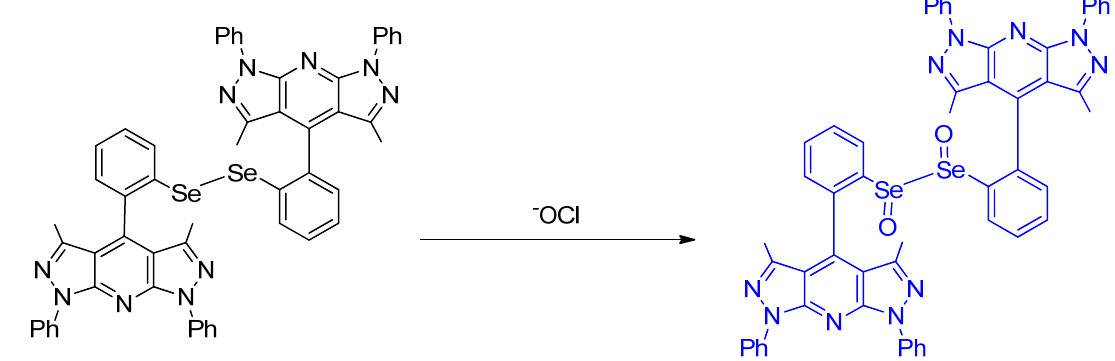
Figure 33. Proposed mechanism of the probe for detection of hypochlorite by Kim et al. Cysteine hydropersulfide (Cys–SSH) plays important roles in the synthesis of sulfur– containing cofactors, cellular signaling, and modulation of enzyme activities. Han et al. in 2016 developed Cy – DiSe , a NIR fluorescent probe for the selective detection of Cys–SSH, based on a heptamethine cyanine probe skeleton. Two moieties were introduced to the probe with a different purpose; bis(2–hydroxyethyl) diselenide can be readily reduced by Cys–SSH due to its stronger nucleophilicity than that of other biothiols (Figure 34); this moiety, therefore, promotes the selectivity of the probe towards Cys–SSH; the terminal galactose residue can allow the probe to target the liver. Cy–DiSe exhibited a ratio fluorescence response to Cys–SSH. After the reaction of the probe with Cys–SSH, the maximum absorption wavelength changed from 790 nm to 614 nm. Cys–SSH triggered the ICT process; the probe showed a spectral blue shift. The maximum emission wavelength underwent a distinct shift from 797 nm ( Φ = 0.05) to 749 nm ( Φ = 0.11). The fluorescence intensity ratio (F 749 nm /F 797 nm ) has a linear relationship with Cys–SSH under those concentrations measured; this indicates that the probe can be used for both quantitative and qualitative ratiometric detection of Cys–SSH. In the analyte selectivity test, the Cy – DiSe showed selective fluorescence responses to Cys–SSH when tested against other species.